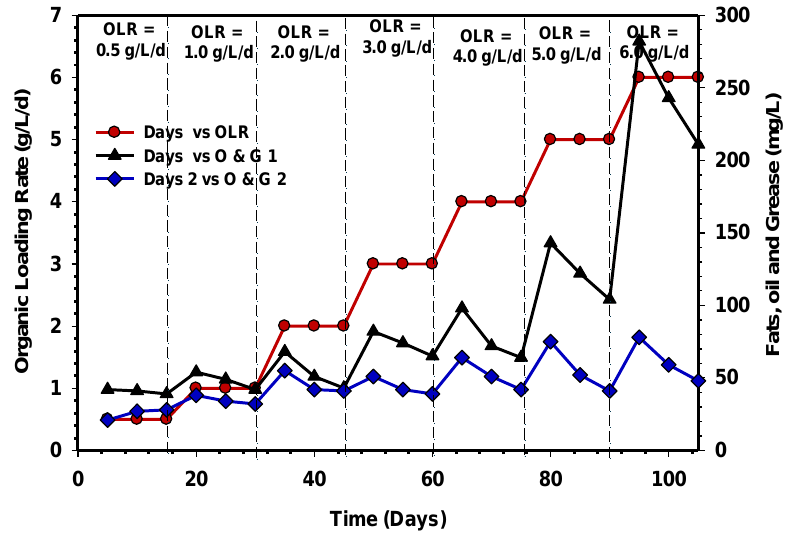
Figure 11. Comparison of FOG removal efficiencies of UASB 1 and 2.